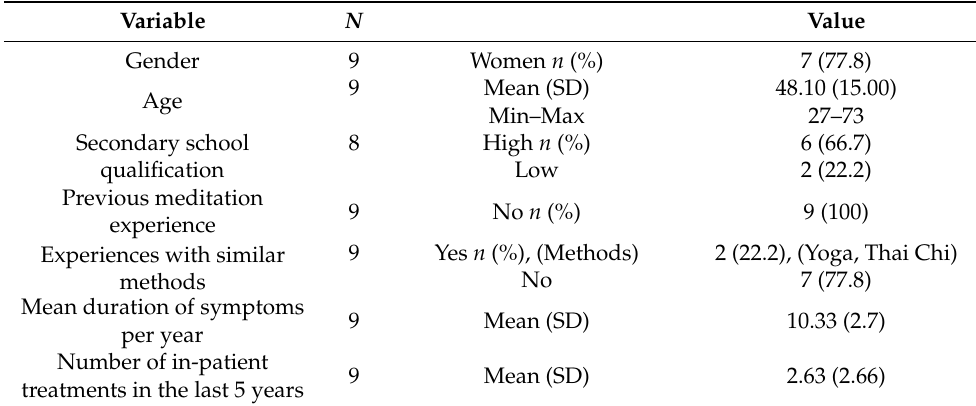
Table 1. Subject